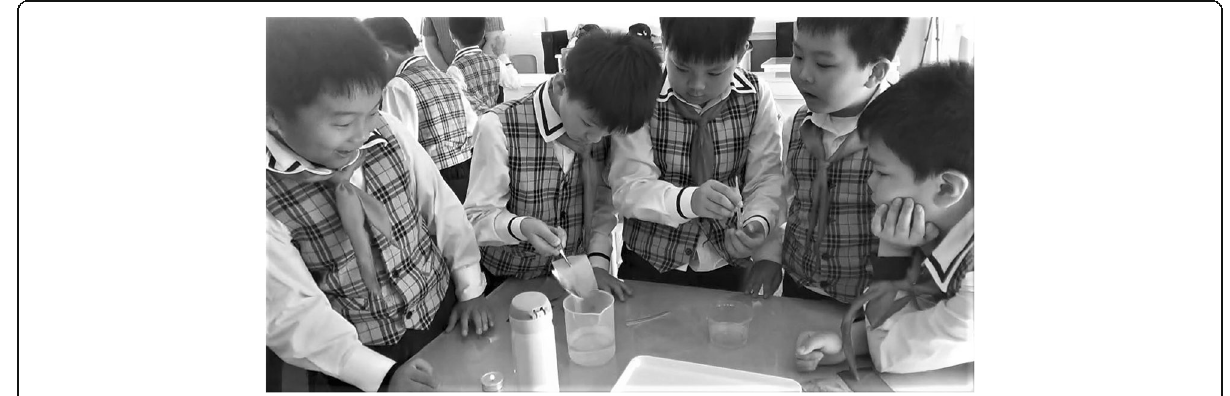
Fig. 2 Turn 2, Wang (left) laughs, Sun holds the burning cloth, and others look